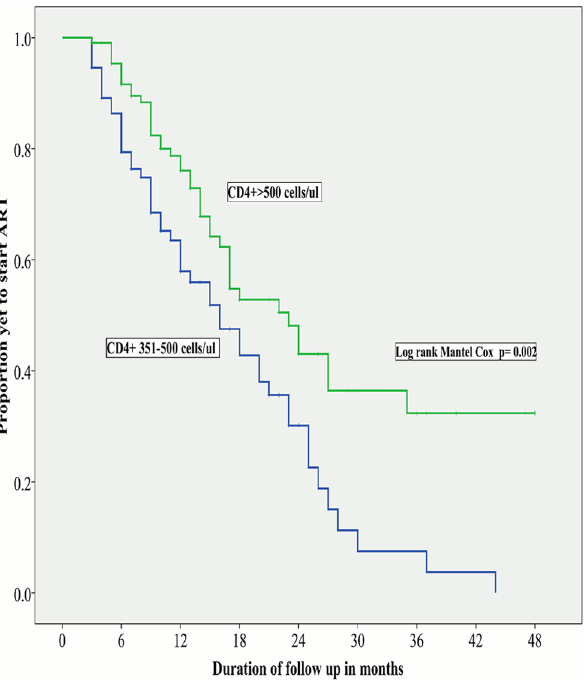
Fig 1. Kaplan-Meier curves of time to initiation of ART in relation to CD4 cell count group. The median time to ART initiation was significantly shorter in participants with CD4 cell count of 351-500cells/ul than those (16months) with CD4 count > 500cells/ul